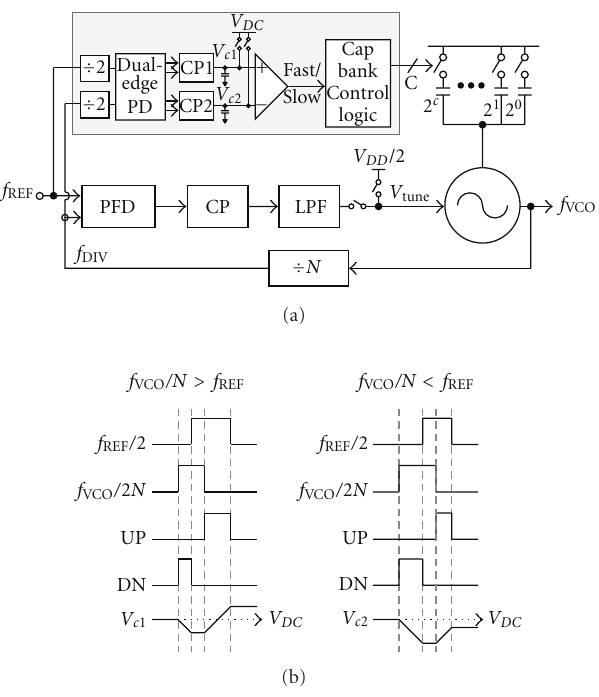
Figure 4: Relative period comparison VCO frequency calibration. (a) Architecture. (b) Operation principle [9, 10].